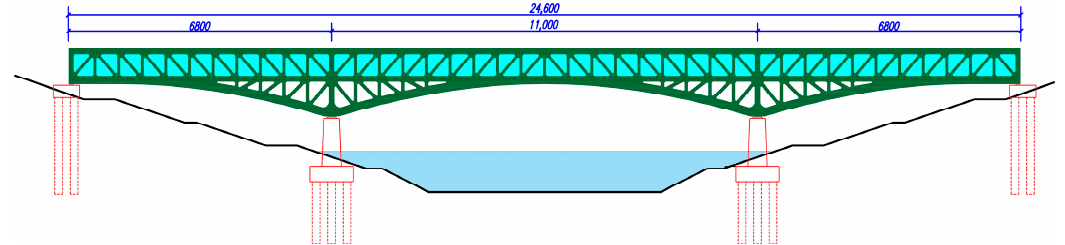
Figure 2. Front elevation of the aqueduct.